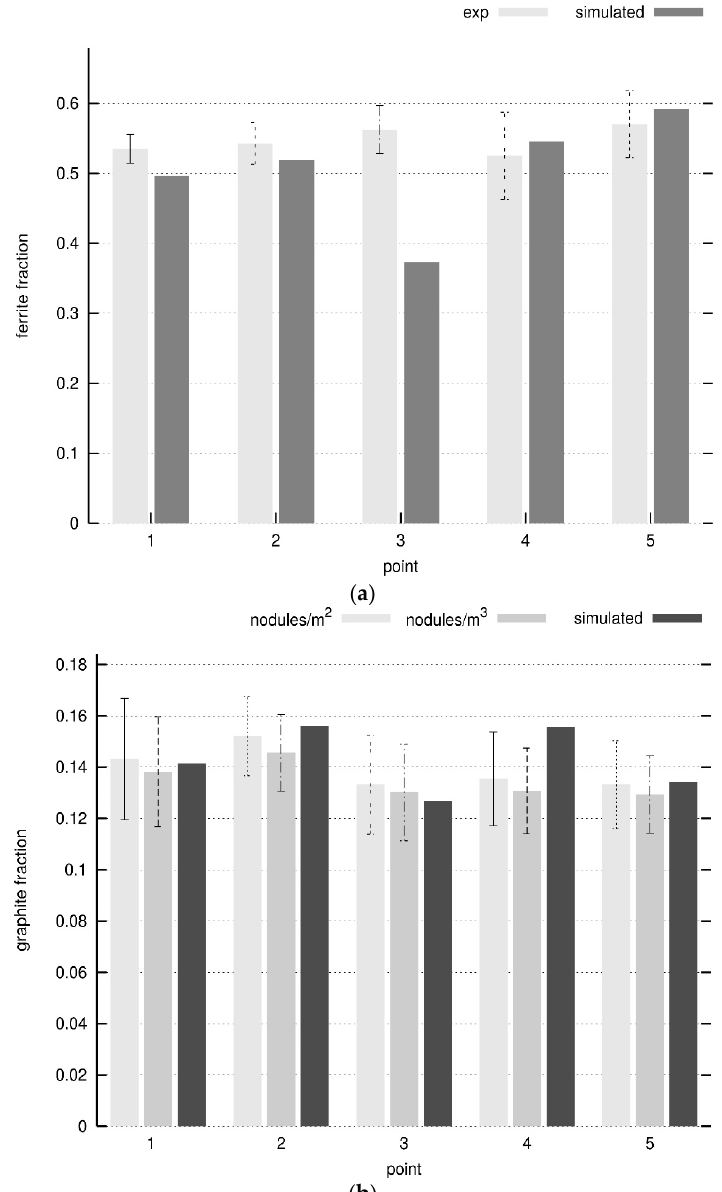
Figure 9. Experimental and simulated ( a ) graphite and ( b ) ferrite fractions at each of the five regions. Standard deviations for the experimental measurements are indicated.